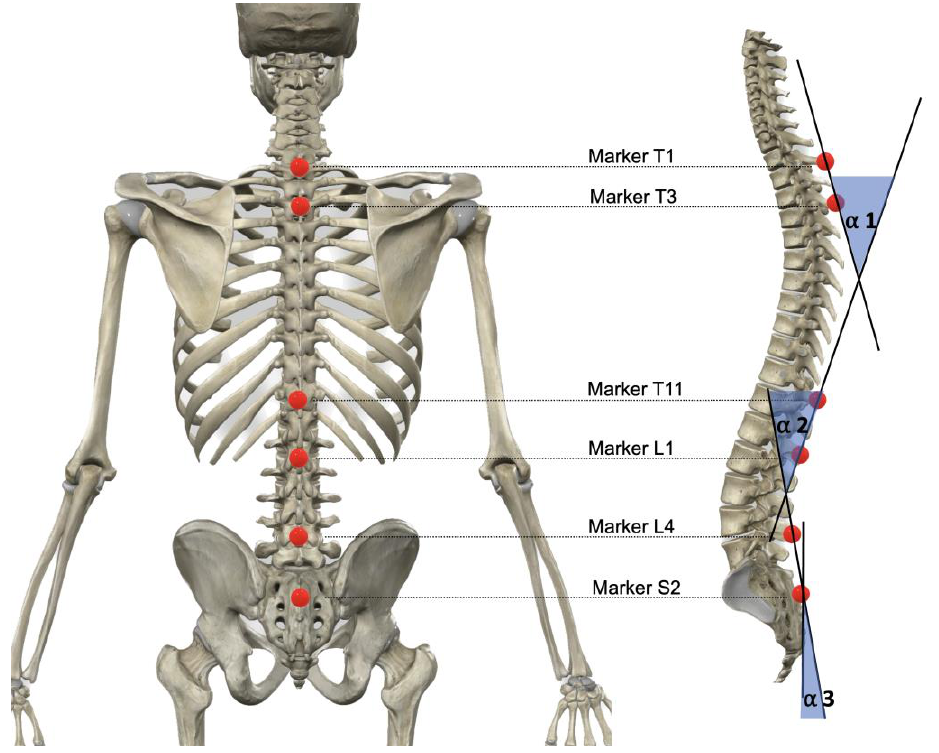
Figure 1. Placement of markers and definition of calculated angles.